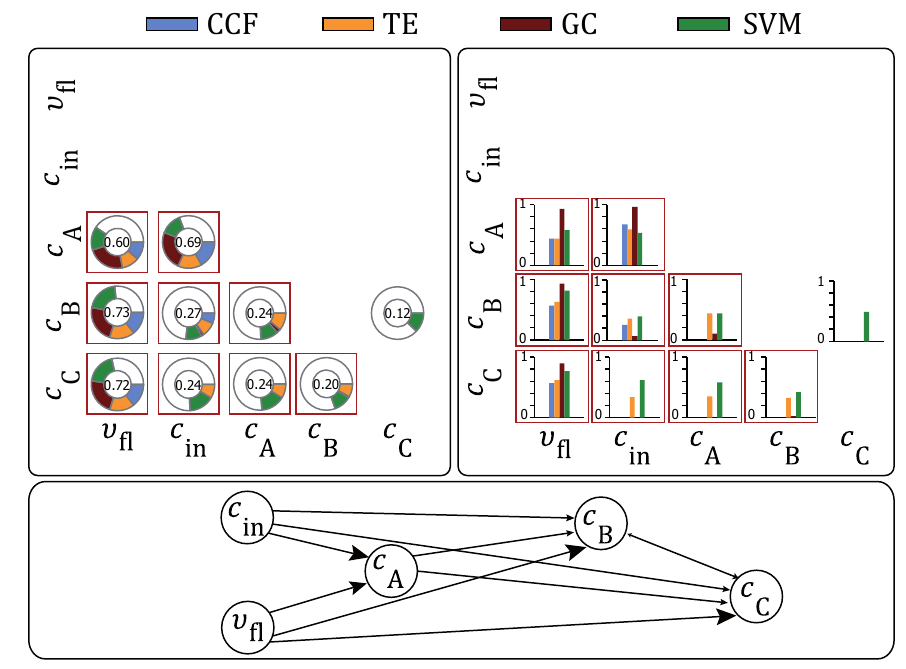
Figure 2. Causal matrices for the stirred-tank-reactor. The red squares describe the expected causal dependencies to be detected by the